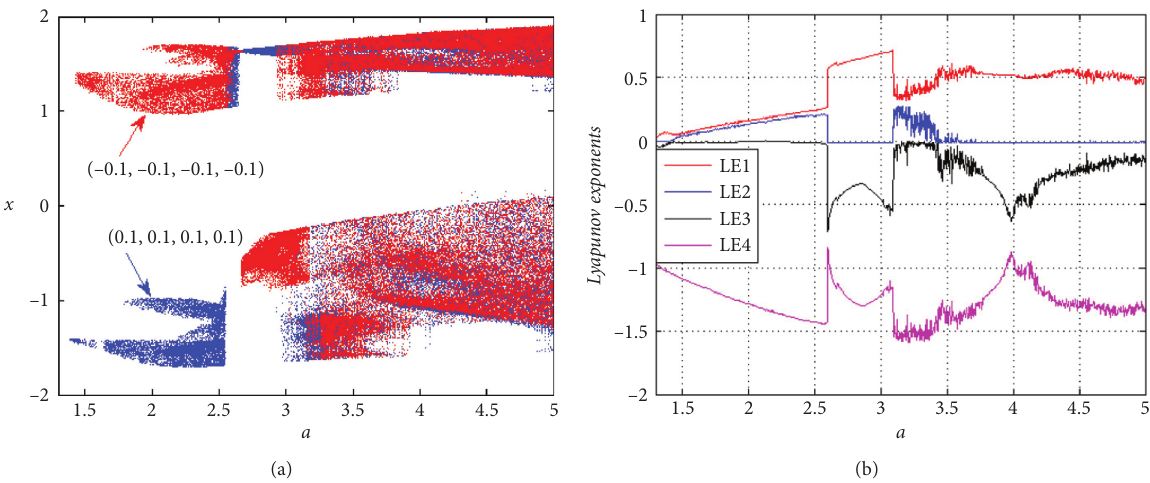
Figure 4: Coexisting bifurcation behaviors with increasing the parameter a in the interval of [1.3, 5]. (a) Coexisting bifurcation diagrams of the state variable ( x ). (b) Lyapunov exponent spectrum with initial conditions ( − 0.1, − 0.1, − 0.1, −